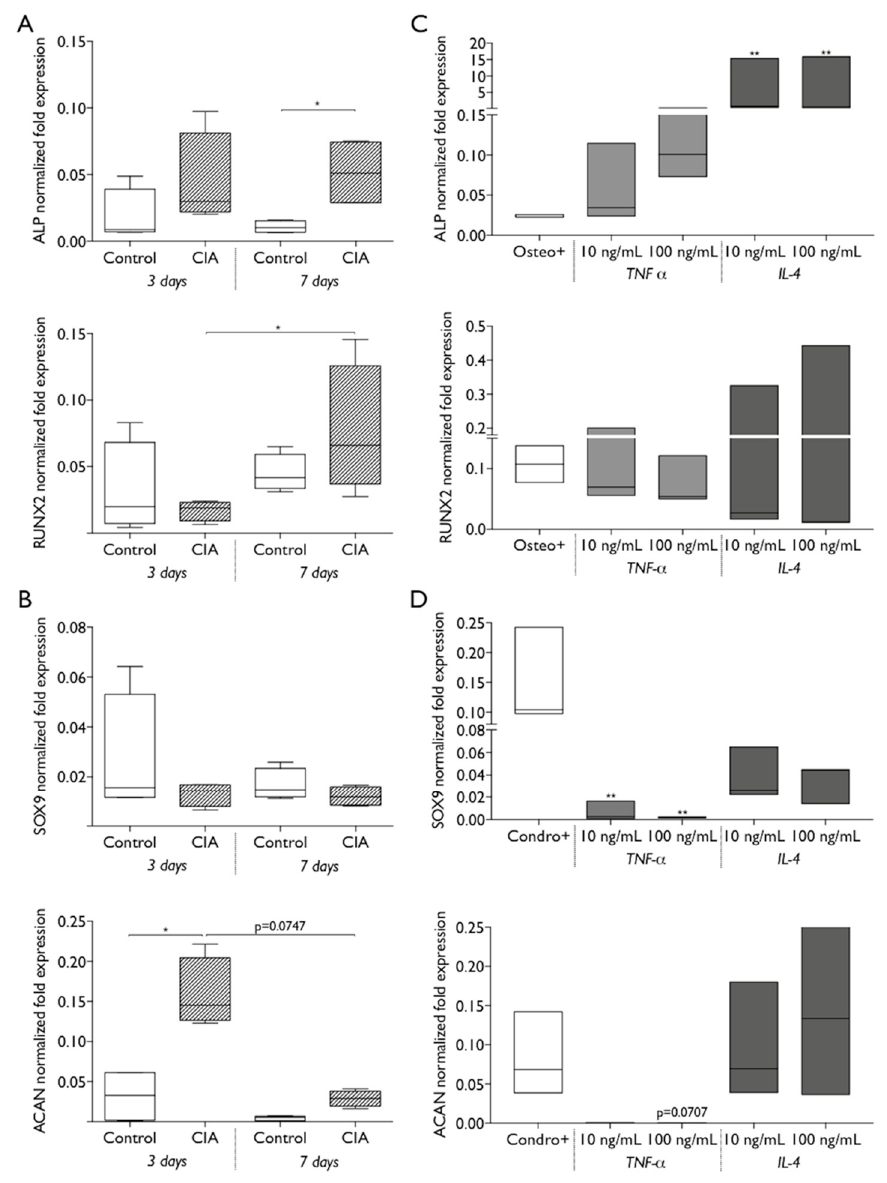
Figure 6. The capacity of MSC di ff erentiation is a ff ected by arthritis induction. The di ff erentiation of control and CIA-MSC were evaluated in absence of chemical inductors, at 3 and 7 days of culture by reverse transcription-quantitative polymerase chain reaction (RT-qPCR) for ( A ) osteogenic marker genes ALP and RUNX2, and ( B ) chondrogenic di ff erentiation genes SOX9 and ACAN. Box plots represent min-to-max distribution of n = 2 to 3 di ff erent animals per group, in 2 independent experiments. * p < 0.05 by Kruskal–Wallis test followed by Dunn’s multiple comparisons test. The e ff ect of 10 ng / mL or 100 ng / mL of TNF- α and IL-4 in the di ff erentiation of control MSC, were evaluated in basal conditions at 3 days by RT-qPCR for ( C ) osteogenic and ( D ) chondrogenic markers. Cells cultured with osteogenic and chondrogenic inductors were used as positive controls for osteogenic (osteo + ) and chondrogenic (chond + ) di ff erentiation. * p < 0.05, ** p < 0.01 determined by Friedman test followed by Dunn’s multiple comparisons